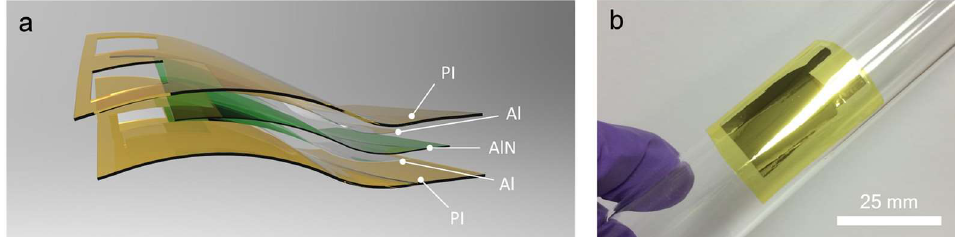
3 of 10 Figure 1. Fabrication procedure of the developed AlN-PNG. Figure 2. ( a ) Schematic illustration and ( b ) photography of the growth process of AlN thin film by PLD. Figure 3a displays a schematic illustration of the fabricated AlN-PNG in exploded view. The thin AlN film that PLD deposited at room temperature separated the top and bottom Al layers that served as electrodes. AlN has a high electric resistance (10 11 –10 13 Ω·cm) and a wide band gap (6.2 ± 0.1 eV) [49]. Previous studies had employed one or more AlN interlayers to build high potential barriers and prevent short circuits between ZnO nanowires (NWs) and the device’s upper electrode [36]. Therefore, compared with other inorganic thin film-based NGs, the developed device did not require an extra insulating layer between the electrodes and the piezoelectric layers. A high potential barrier was provided by the high resistivity of the AlN for preventing undesired current leakage across the electrodes. In order to reduce the risk of performance failure or an immune response, two PI films served as the protective layers that encapsulated the device and made it potentially suitable for implantable biomedical applications [50]. The PI films aim